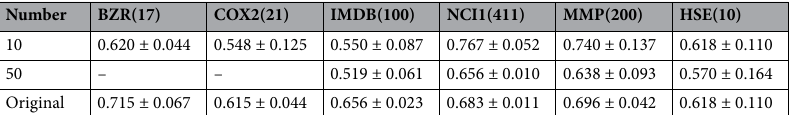
Table 4. AUC values (mean ± std) of small number of anomalous graphs in test set, where () indicates the existing number of graph anomalies in the original test